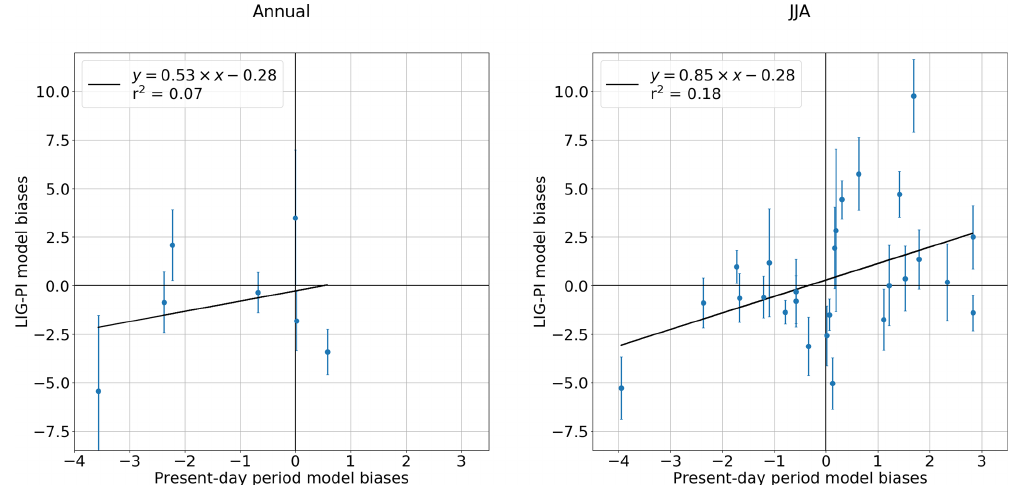
Figure 18. Linear regression of surface temperature biases in the historical simulation versus surface temperature biases in the lig127k simulation. Blue circle markers represent the model biases at LIG terrestrial and marine ice core sites. The coefficient of correlation ( r 2 ) is calculated for each regression line. To compute model biases for the historical simulation, we use ERA-Interim near-surface air temperature data (1980–2005), the WOA13-v2 ocean temperature data (1985–2004) and the first member of the IPSL-CM6A-LR historical simulations. The error bars are plotted in blue and represent the uncertainty on the surface temperature biases during the Last